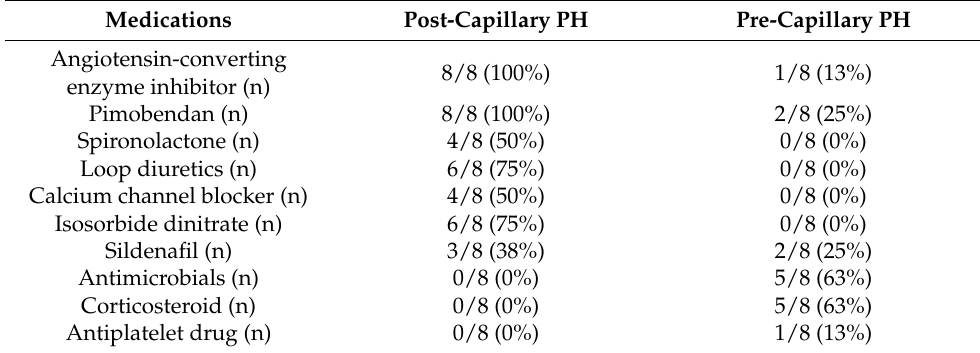
Table 2. Medications which 16 dogs with PH received at the time of